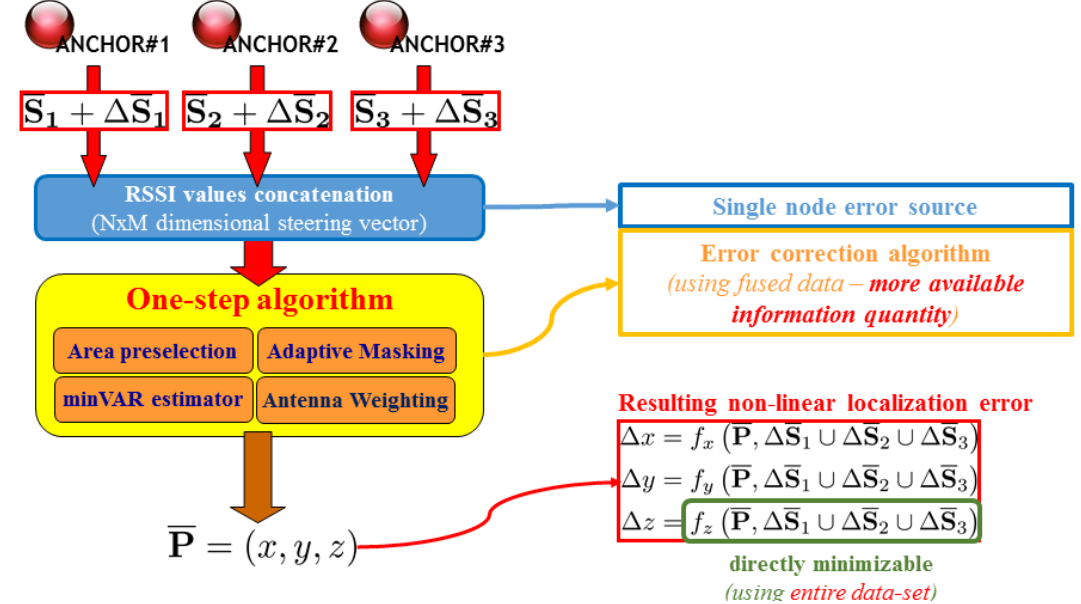
Figure 5. Error propagation scheme for RSSI DoA-fused data